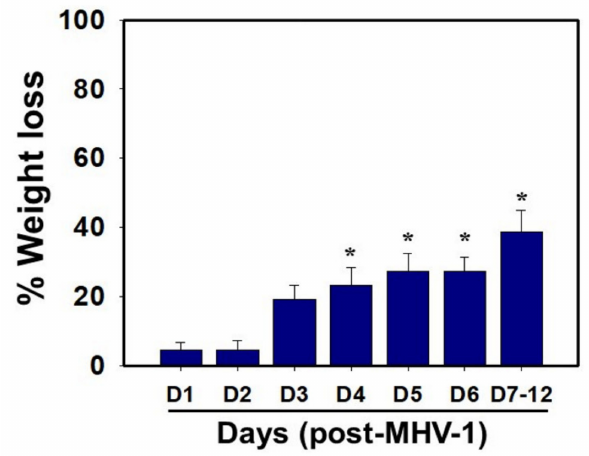
Figure 4. Body weight losses in MHV-1 infected mice. MHV-1 inoculated mice lost 20–40% of body weight over days 3–8, corresponding well with the severity of the disease ( n = 16). * p < 0.05 versus